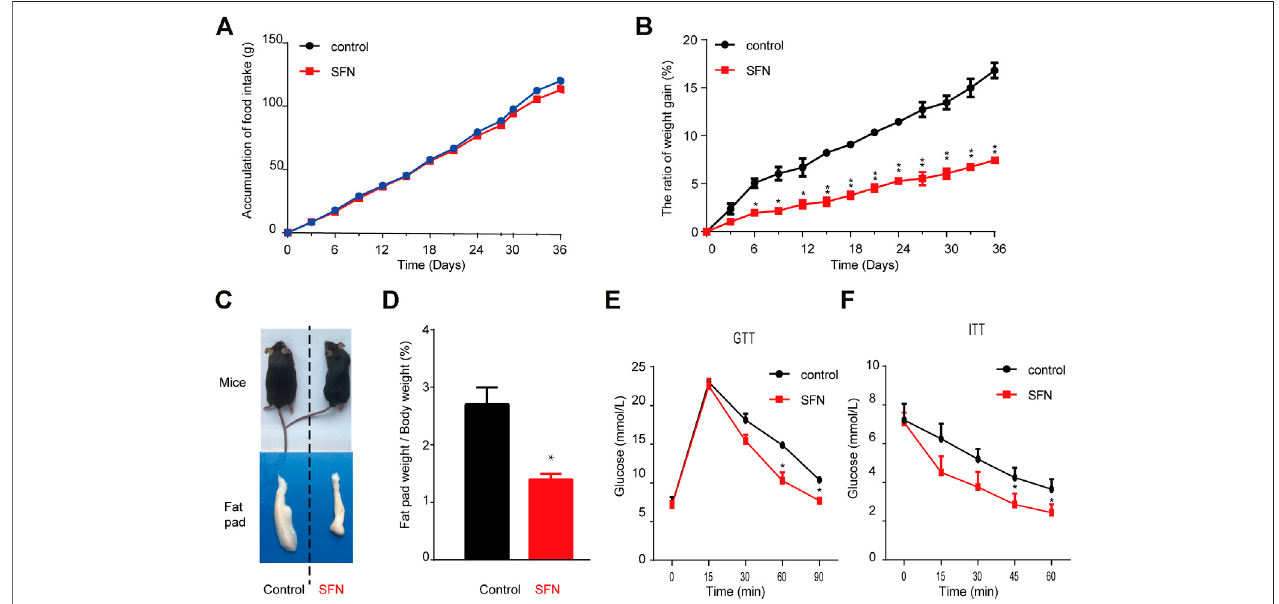
FIGURE 5 | SFN prevented HFD-induced obesity. (A,B) SFN had no effect on food intake but decreased body weight gain, n (cid:2) 7/group, * p < 0.05, ** p < 0.01 vs. control. (C) RepresentativephotographofHFD-inducedmiceandSFN-treatedHFD-inducedmice (D) Percentoffatpadweighttothewholebodyweight. (E,F) GTTand ITTincontrolandSFN-treatedgroups. n (cid:2) 7/group.Alltheresultswereexpressedingraphwithmean ± SD.Statisticalsigni fi cancewasevaluatedbyStudentttest.*and ** represent the signi fi cant difference at p < 0.05, p < 0.01 vs control